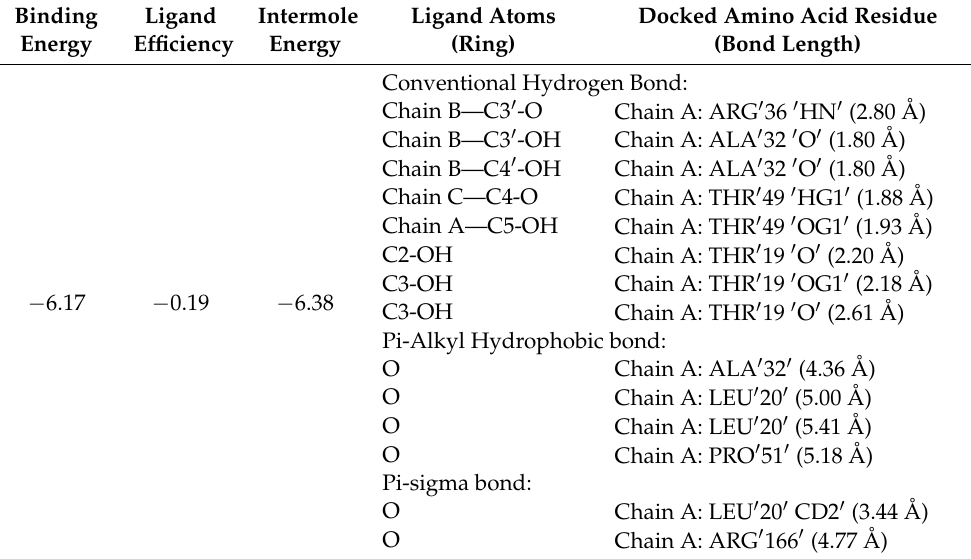
Figure 3. Effect of orientin on liver inflammatory markers. The CCl 4 -induced mice were administered for orientin 1 mg/kg body weight of mice for 7 days and liver tissues were excised. Liver homogenate was prepared using ice cold cell lysis buffer with 0.1% DTT. ( A ) The TNF- α was estimated using a Cayman ELISA kit. ( B ) IL-6 was estimated in liver lysate using a mouse Cayman ELISA kit. ( C ) IFN- γ was estimated in liver lysate using a mouse Cayman ELISA kit. ( D ) IL-8 was estimated in liver lysate using a mouse Cayman ELISA kit. ( E ) mRNA expression of ZEB-2 and PTEN using real time PCR. ( F , G ) Protein quantification of ZEB-2 and PTEN in CCl 4 -induced and CCl 4 with orientin treatment using immunoblot-based techniques. (The data are represented as the mean ± SD.) p < 0.05. * Represents the significant comparison with control and CCl 4 -induced groups. Table 1. Interactions of orientin and ZEB2 receptor residues of target